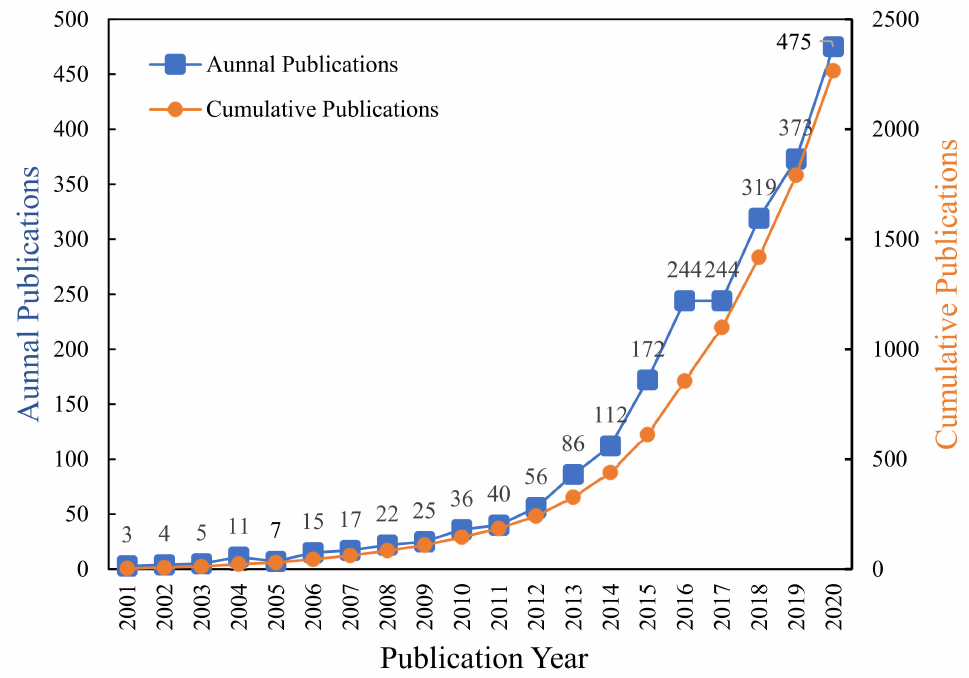
Figure 2. Annual publication distribution in community resilience research over the past two